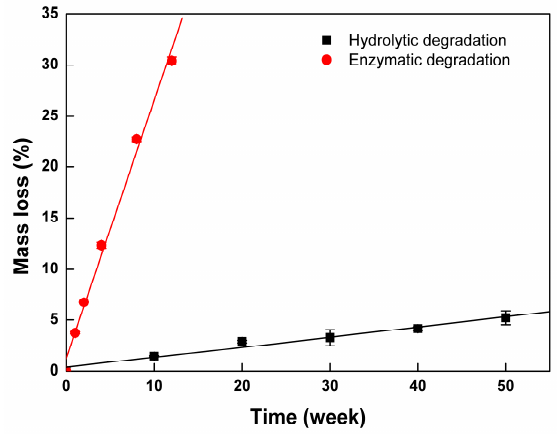
Figure 9. The degradation behavior of the PTMC 256 -0.1 with and without the lipase.